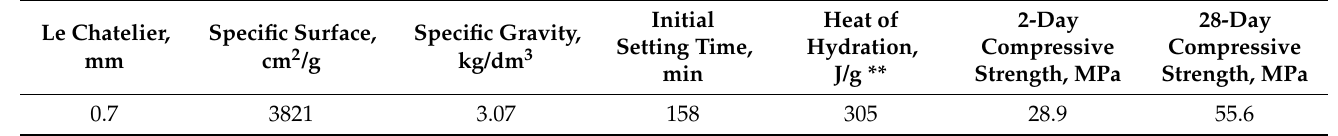
Table 3. Physical and mechanical properties of cement.